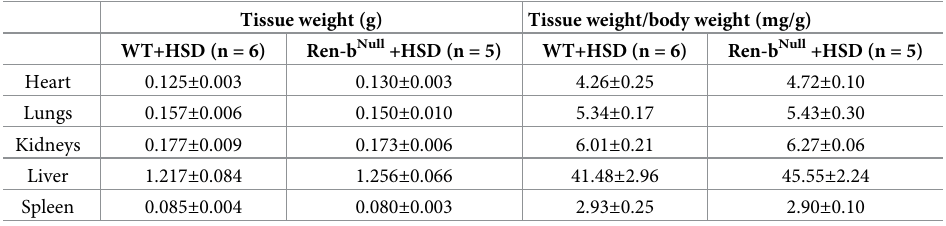
An unpaired t-test was used for data